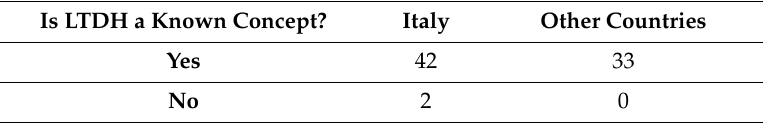
Table 2. Participants’ knowledge of the LTDH concept before taking the survey.